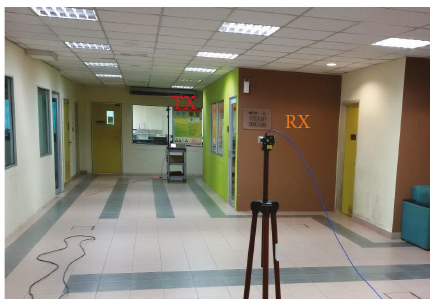
Figure 1: Measurement environment at (new WCC) block P15a- UTM. Table 1: Assessment setup